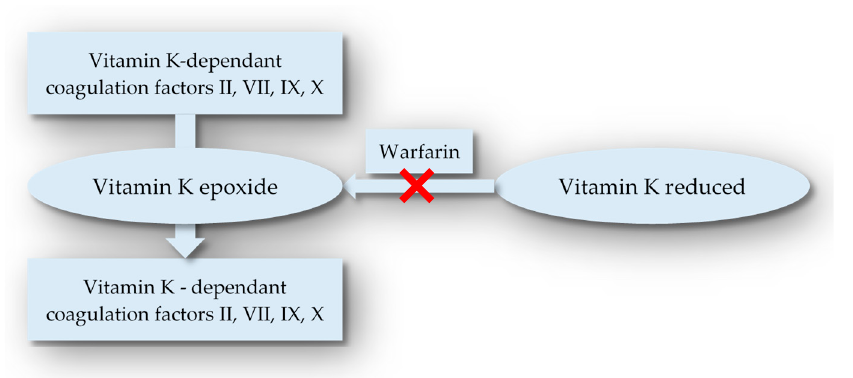
Figure 1. Warfarin mechanism of action .